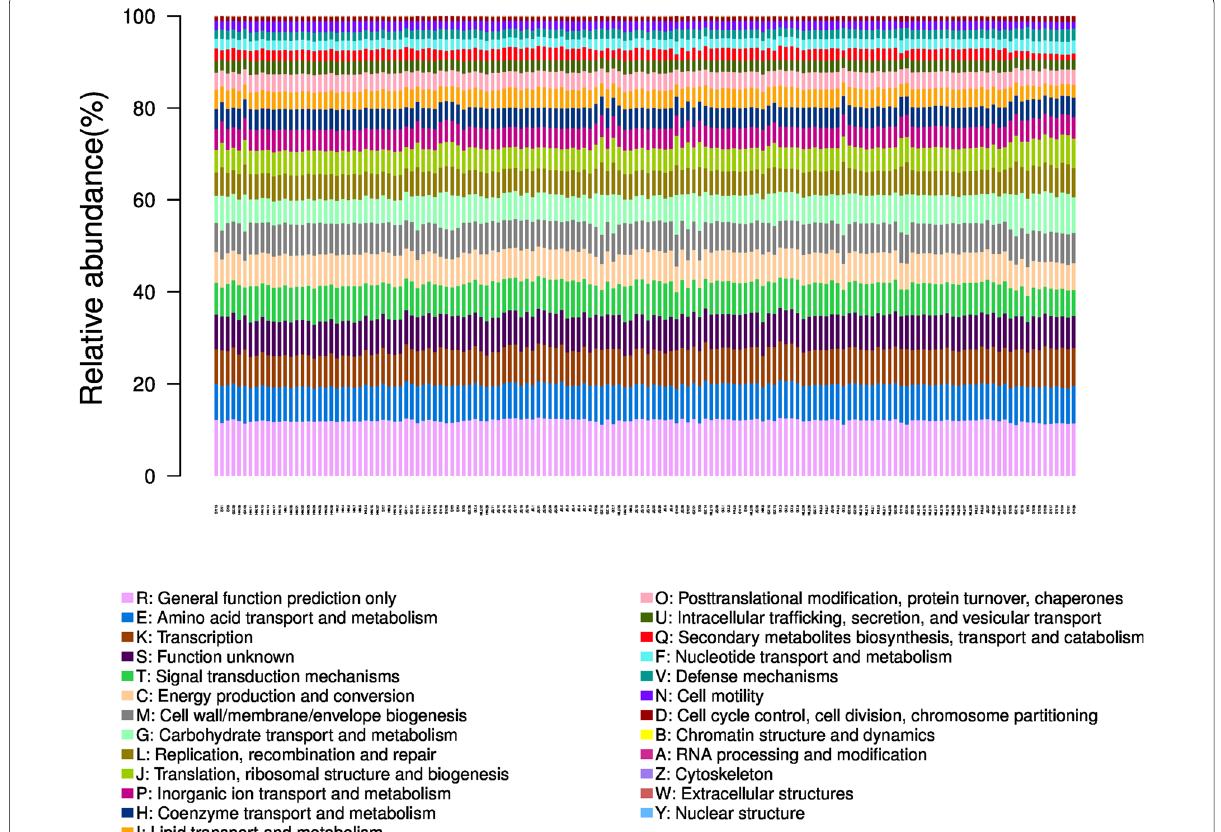
Fig. 5 Clusters of orthologous groups of proteins (COG) functional prediction of the significantly different abundant bacteria between BIO-treated and untreated soil samples at five rice paddy sites. The HN_CK, HN_TRE, JS_CK, JS_TRE, HLJ_CK, HLJ_TRE, GZ_CK, GZ_TRE, SY_CK and SY_TRE represent BIO treatedt and untreated soil samples at the five rice paddy sites in China